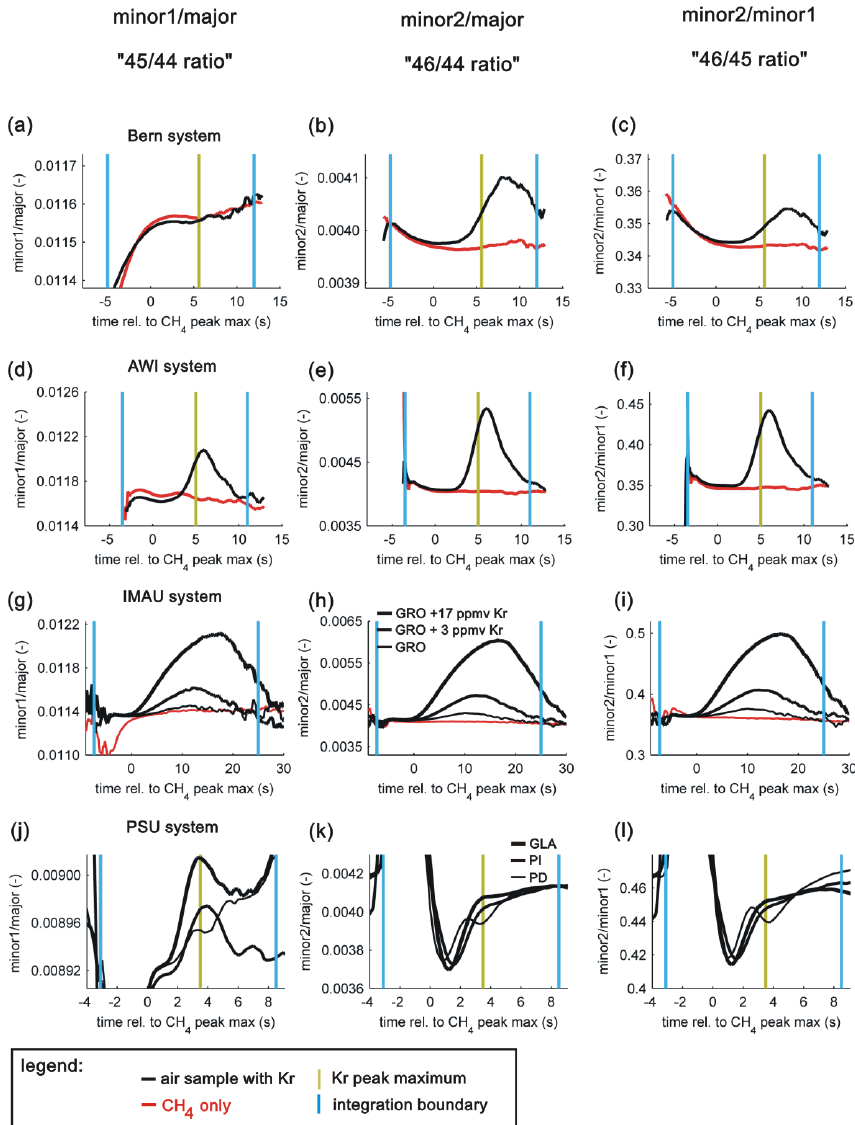
Fig. 2. Comparison of the ion current ratios of the four systems (from top to bottom: Bern, AWI, IMAU, PSU). The left column shows the minor1/major ratio (“45/44 ratio”); the middle column shows minor2/major (“46/44 ratio”), the right column minor2/minor1 (“46/45 ratio”). Natural-air samples and air samples with added Kr are plotted as black lines, and injections of pure CH 4 are shown as red lines, illustrating the anomalies seen in the Kr containing samples. Blue vertical lines mark the left and right integration limits. Green vertical lines mark the maximum position of the Kr peak where we could determine its precise position. The Kr interference in the AWI system is visually more pronounced compared to the Bern system due to the differences in peak separation and focusing of the IRMS.